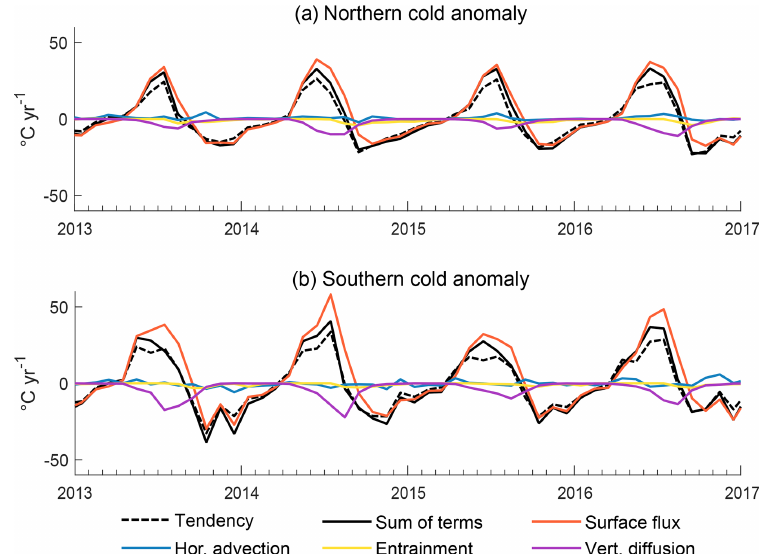
Figure A4. The dominant terms of the mixed-layer temperature budget from 2013–2016 ( ◦ Cyr − 1 ) in ECCOv4-r4, averaged over the (a) northern and (b) southern half of the cold blob region. The dashed black line shows the model temperature tendency, and the solid black line shows the sum of the temperature budget terms driving the temperature change. The remaining lines represent these individual processes: the surface heat flux (orange), horizontal advection (blue), vertical entrainment (yellow), and vertical diffusion (purple). Lateral induction and horizontal diffusion are not shown; both are